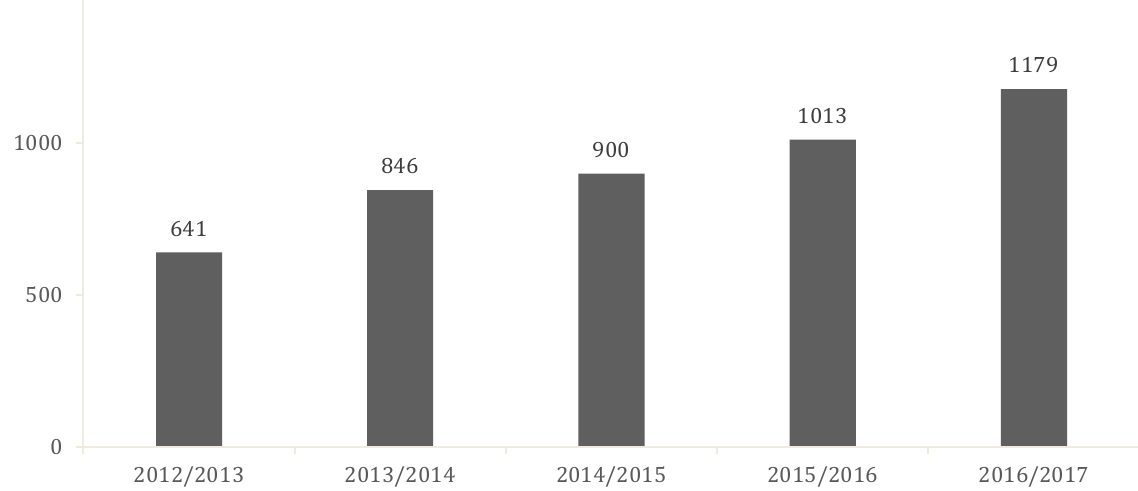
Figure 1. Rapid increase in the number of fully online course sections across